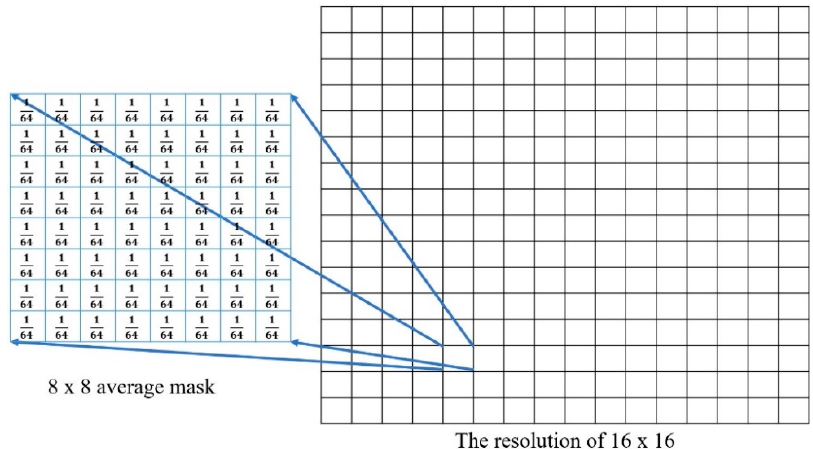
Figure 3. DVS data are preprocessed, and overall resolution reduced from 128 × 128 to 16 × 16, where each ‘superpixel’ represents a block of 64 (8 × 8) original pixels. The decision whether there is spike at a ‘superpixel’ is based on having a set number of spikes in the pixels that it covers within a specific time window. If the first layer of the SNN has one neuron for each pixel, then required number of neurons is reduced from 16,384 to 256—some loss of resolution but a significant advantage for the neural network training phase.